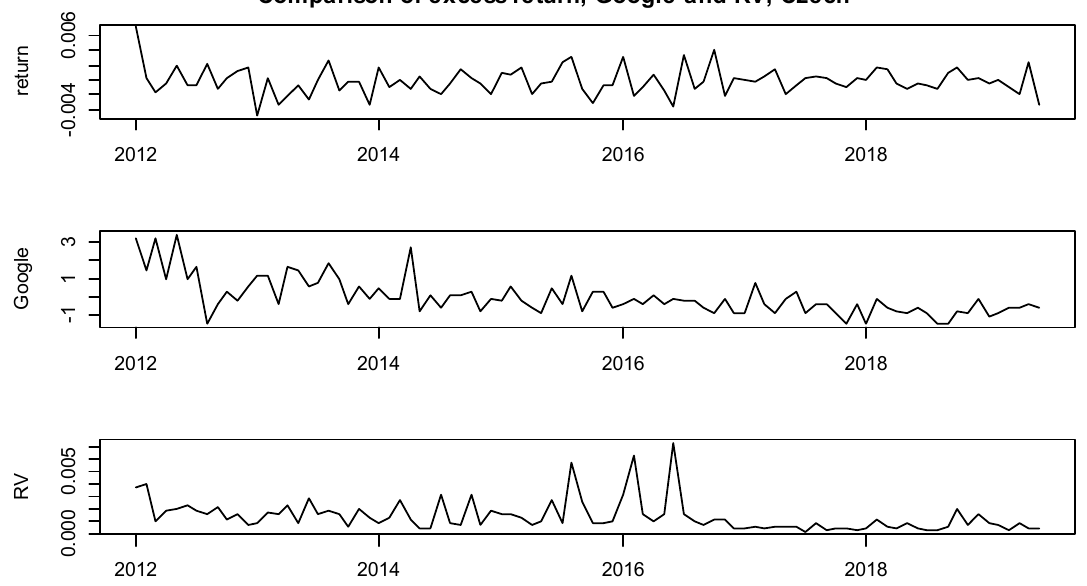
Figure A6. Comparison of monthly series: Excess return, RV and Google search volume, Czech Republic.